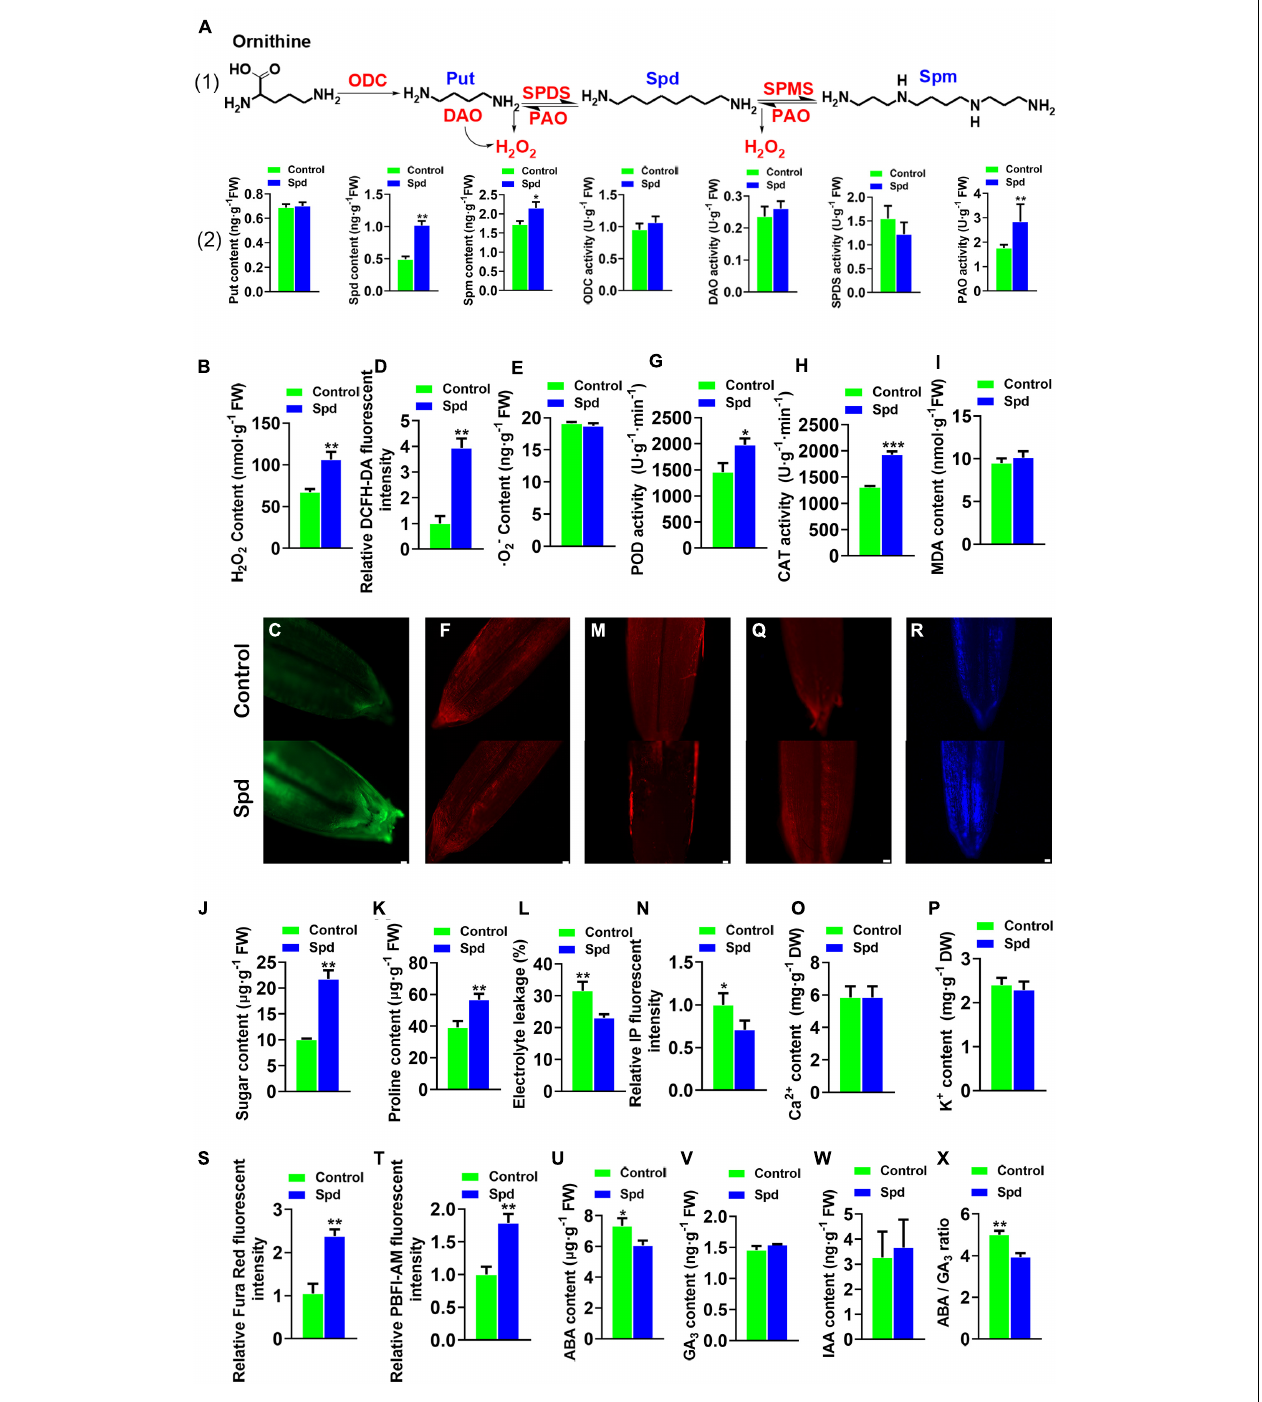
FIGURE 1 | Physiological-biochemical properties of Leymus chinensis seeds after 12 h of soaking. (A) The polyamine biosynthesis pathway of Leymus chinensis , enzymatic activities, relative gene expression, and the contents of Put, Spd, and Spm. (B) Content of H 2 O 2 . (C) Fluorescence localization of H 2 O 2 , bar = 100 µ m. (D) Quantification of DCFH2-DA fluorescence intensity. (E) Content of O 2 - . (F) Fluorescence localization of · O 2 - , bar = 50 µ m. (G) POD activity. (H) CAT activity. (I) Content of MDA. (J) Content of sugar. (K) Content of proline. (L) Electrolyte leakages. (M) Fluorescence localization of plasma membrane integrity, bar = 100 µ m. (N) Quantification of PI fluorescence intensity. (O) Content of Ca 2 + . (P) Content of K + . (Q) Fluorescence localization of Ca 2 + , bar = 100 µ m. (R) Fluorescence localization of K + , bar = 100 µ m. (S) Quantification of Ca 2 + fluorescence intensity. (T) Quantification of K + fluorescence intensity. (U) Content of ABA. (V) Content of GA 3 . (W) Content of IAA. (X) The ratio of ABA/GA 3 . Vertical bars indicate mean ± SD ( n = 3), and * or ** or *** indicates a significant difference at the level of p < 0.05 or at the level of p < 0.01 or at the level of p < 0.001, respectively. Put, putrescine; Spd, spermidine; and Spm, spermine; POD, peroxidase; IAA, indole acetic acid; CAT, catalase; ABA, abscisic